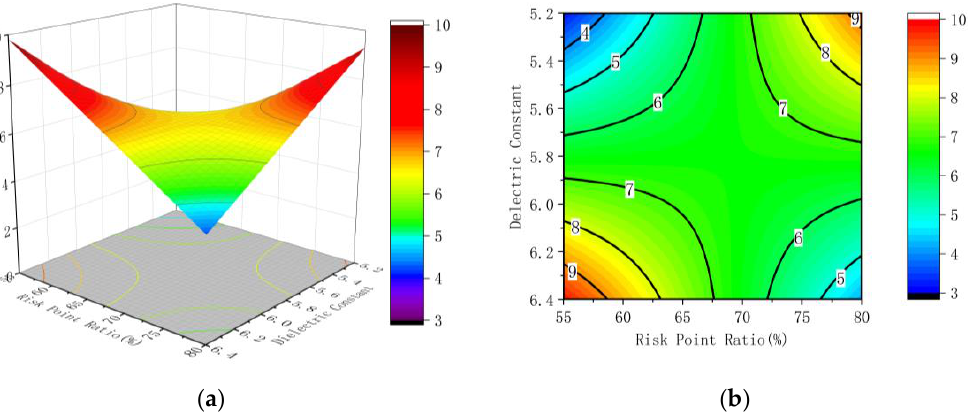
Figure 14. Response surface diagram and contour diagram of the risk point ratio and the delectric constant to the void ratio; ( a ) the response surface diagram ( b ) the contour diagram.